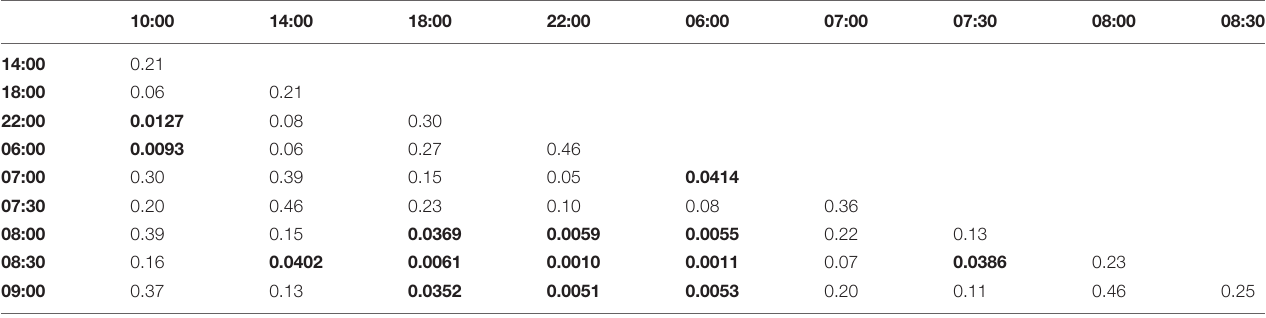
p-values less than 0.05 shown in bold. TABLE 2 | Adjusted p -values for Artificial Rain Experiment (12:00-14:00 trained).